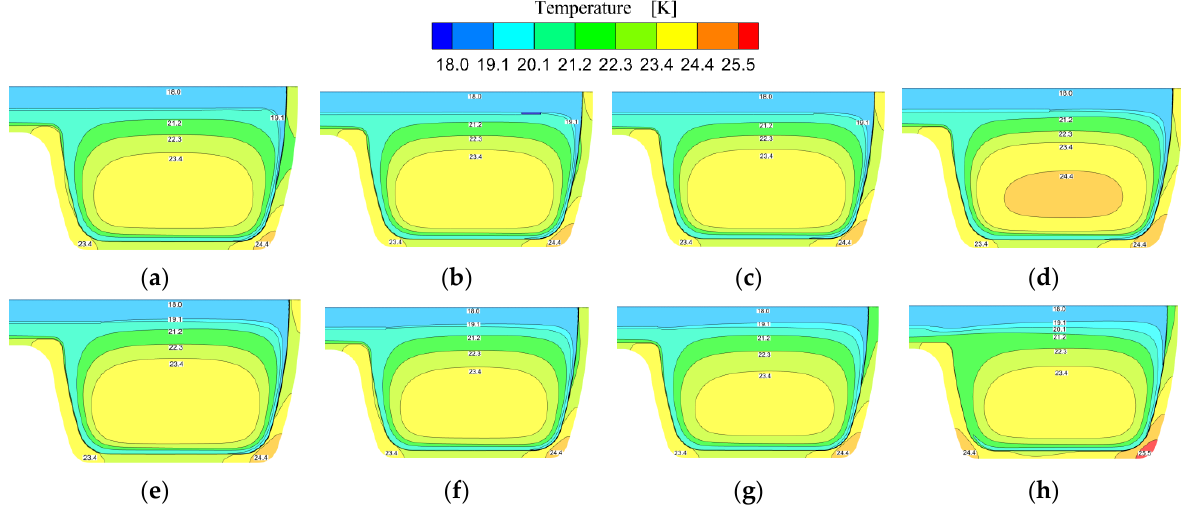
Figure 13. Temperature contour of moderator at proton beam power = 500 kW: ( a ) H/D = 0.5; ( b ) H/D = 1; ( c ) H/D = 1.5; ( d ) H/D = 3; ( e ) H/D = 4.5; ( f ) H/D = 5; ( g ) H/D = 5.5; ( h ) H/D = 6.